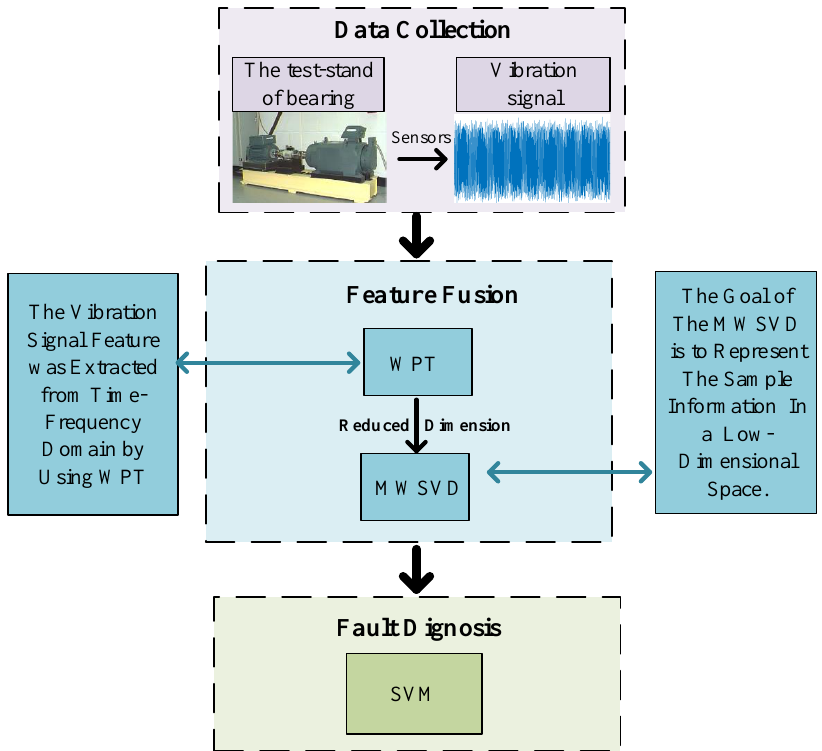
Figure 1. The flowchart of the bearing fault diagnosis method that is based on feature